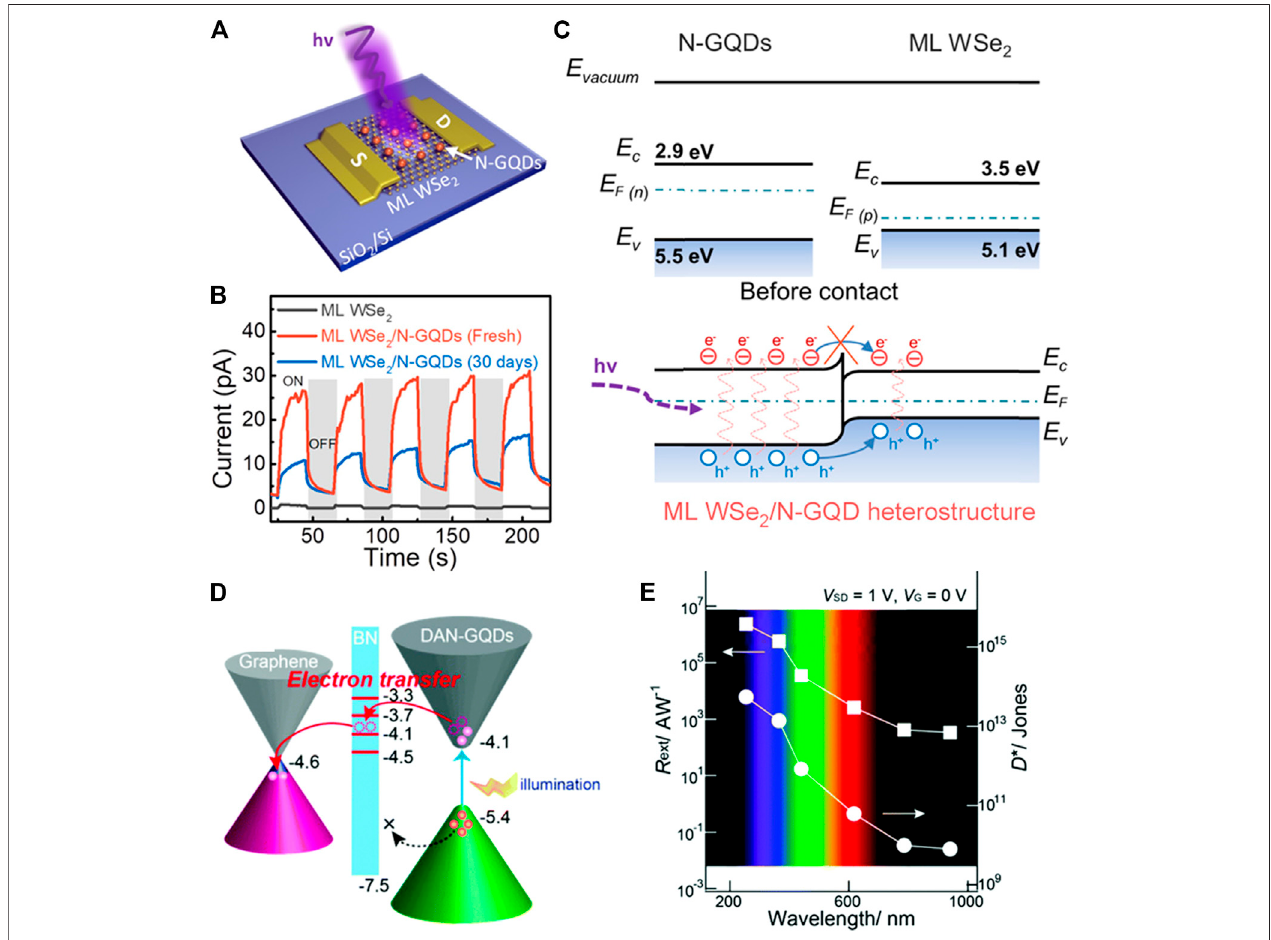
FIGURE 4 | (A) Schematic of the hybrid ML WSe 2 /N-GQD PD. (B) Photocurrent of ML WSe 2 , ML WSe 2 /N-GQD devices and after 30 days under ambient condition. (C) Energy band diagram before and after the formation of ML WSe 2 /N-GQD heterostructure. (D) Schematic illustration of the energy level of the graphene/ BN-NS/DAN-GQD hybrid PD under light illumination. (E) Photoresponsivity and detectivity vs. incident power (wavelength ranging from 254 to 940 nm) for the device. (A – C) Reprinted with permission from ACS Appl. Mater. Interfaces, 2018, 10, 10322 – 10329. Copyright 2018 American Chemical Society. (D – E) Reprinted